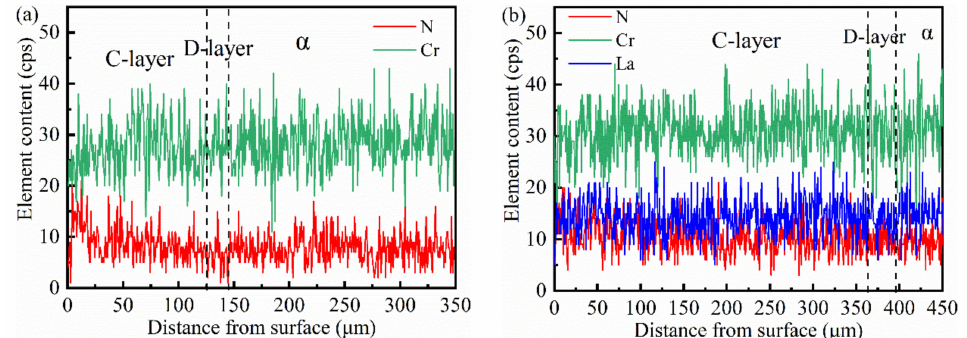
Figure 8. Element depth profile of modified layer of 3Cr13 steel after plasma nitriding for 12 h ( a ) Without RE ( b ) With